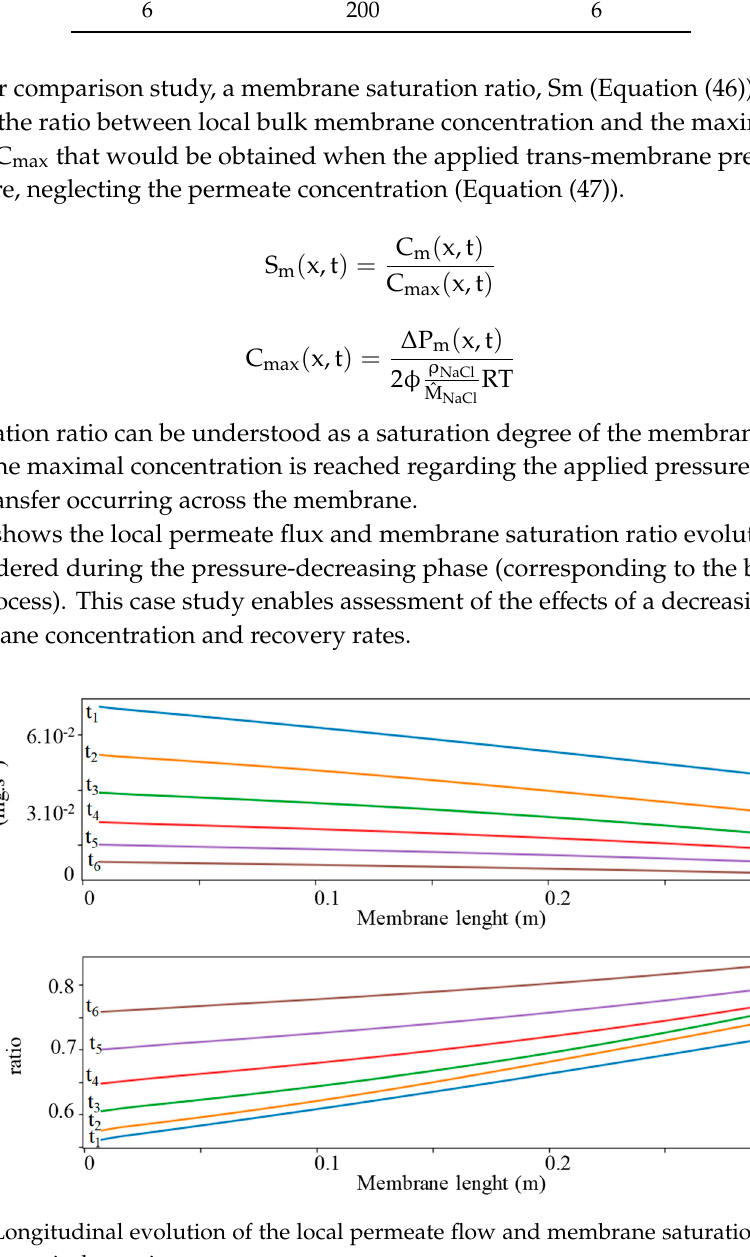
Figure 14. Longitudinal evolution of the local permeate flow and membrane saturation ratio when applied pressure is